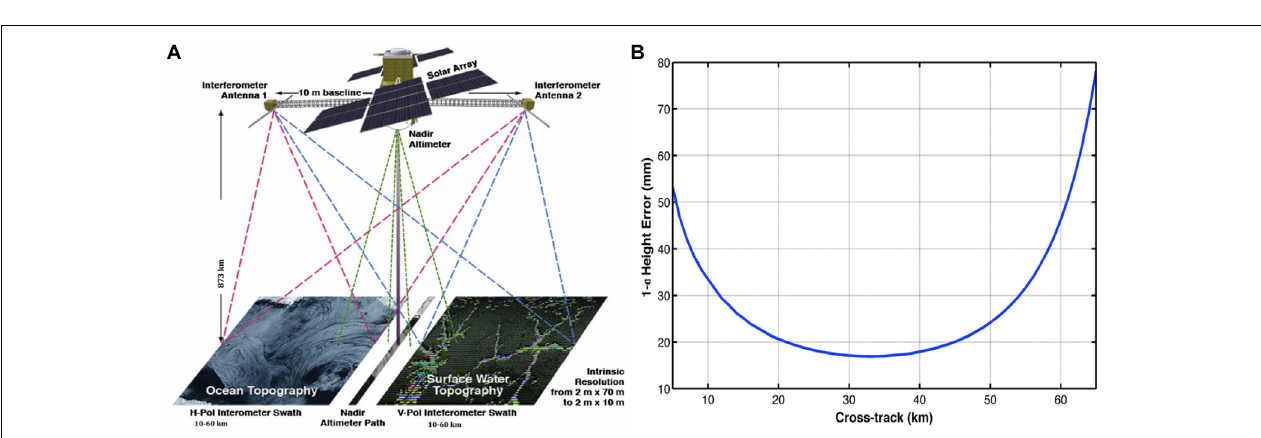
FIGURE 1 | (Left) SSH wavenumber spectra in the Kuroshio region from four altimetric missions. The –11/3 slope is shown by the dashed line (from panel b of Figure 1 in Le Traon et al., 2008). (Right) Global SSH wavenumber spectral slopes (with a reversed sign) in the 70–250 km range (from panel b of Figure 3 in Xu and Fu, 2012) ( copyright 2012, American Meteorological Society ).